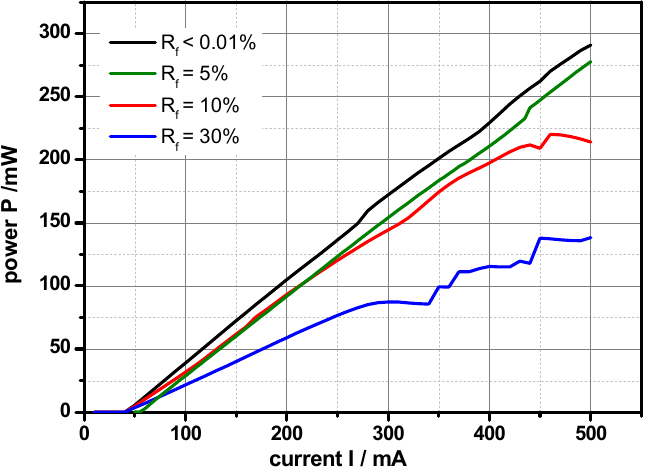
Figure 1. Power-current characteristics of 3 mm long 780 nm DFB (distributed feedback) diode lasers having different front facet reflections between R < 0.01% (black), 5% (green), 10% (red), and 30% (blue).